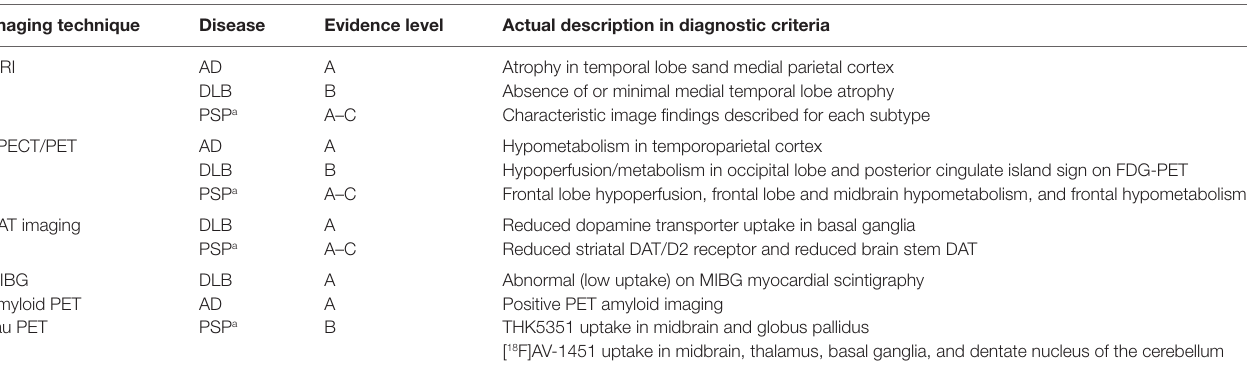
TABLe 1 | Summary of neuroimaging techniques used as